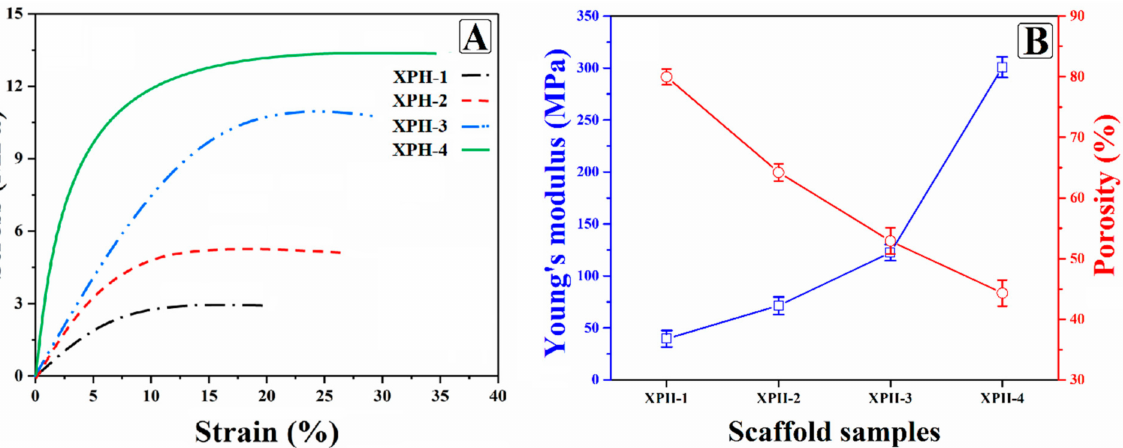
Figure 4. The mechanical behavior of hybrid nanocomposite scaffolds has been investigated through ( A ) stress–strain curve and ( B ) relation of Young’s modulus and porosity. Table 1. The mechanical properties, molar crosslink density, pore size, and porosity of polymeric hybrid nanocomposite scaffolds. Sample Strain